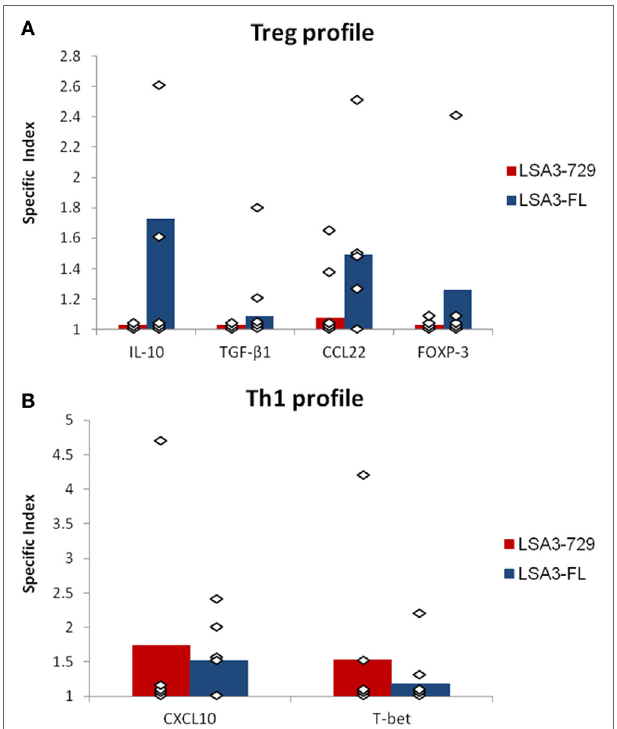
FigUre 4 | Evaluation of human T-helper type 1 (Th1) and T regulatory (Treg) responses elicited by liver stage antigen 3-full length (LSA3-FL) or liver stage antigen 3-729 (short form) (LSA3-729). At day 28 after immunization, humanized-spleen cells-NOD-SCID-gamma null (Hu-SPL-NSG) spleen cells were cultured in vitro with or without antigen stimulation. The expression of molecules characteristic of a Treg response (cytokines IL-10 and TGF- β 1, chemokine CCL22, and transcription factor FOXP-3) (a) or a Th1 response (chemokine CXCL10 and transcription factor T-bet) (b) was measured by real-time reverse transcription PCR. The specific index is the ratio of normalized relative quantity (NRQ) of in vitro antigen stimulated cells over NRQ of non stimulated cells. Data are presented as mean values of the results obtained with each immunizing antigen using human spleen cells from five different donors. Each dot corresponds to the result obtained with spleen cells pooled from mice of one experimental group.